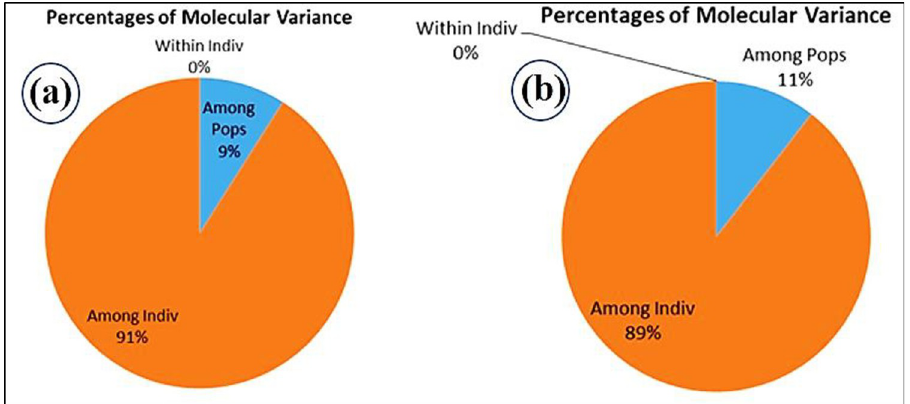
Fig 4. AMOVA analysis based on populations separated with leaf blast scores (a) and neck blast scores